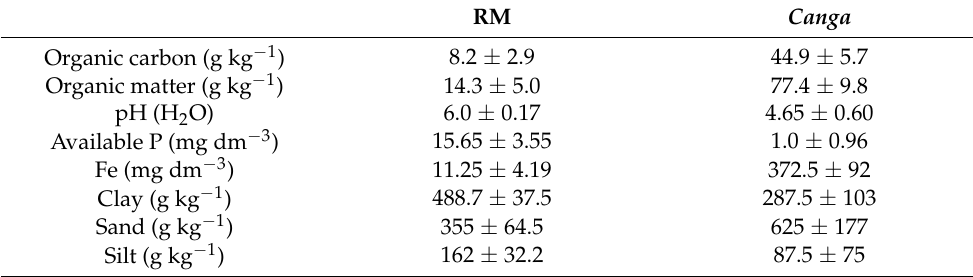
Table 1. Characteristics of substrates associated with Mimosa acutistipula growing in canga and rehabilitating minelands (RM). Soil results are mean ± standard deviation for n = 4.